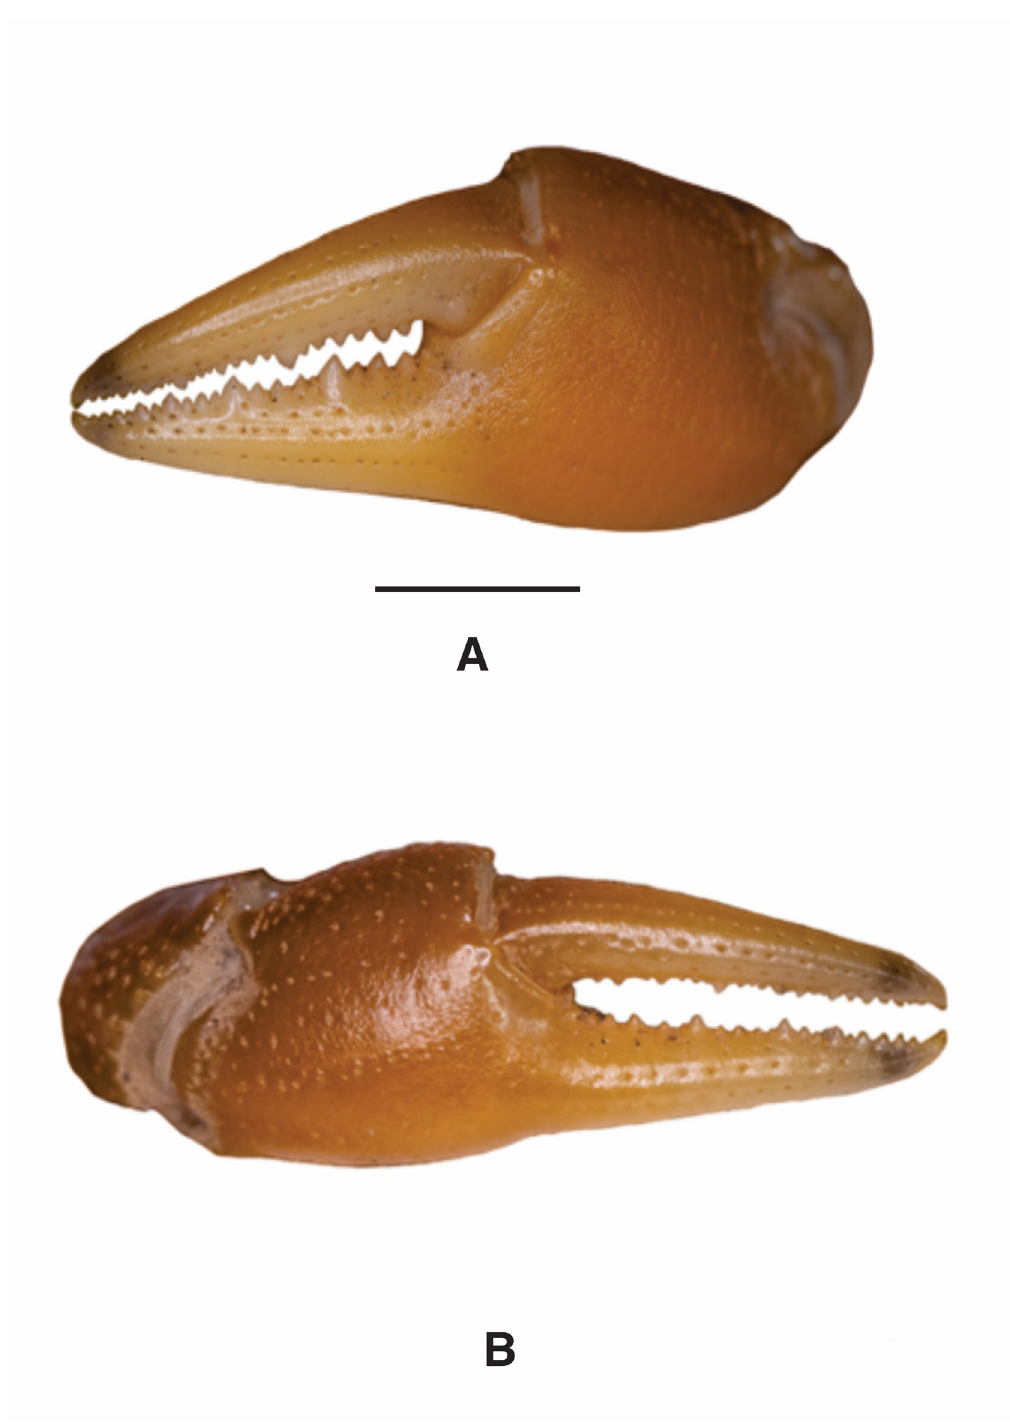
Fig. 4. Potamonautes mariepskoppie sp. nov., ♂, holotype (SAM A-094471) A . Major right cheliped. B . Minor left cheliped. Scale bar = 10